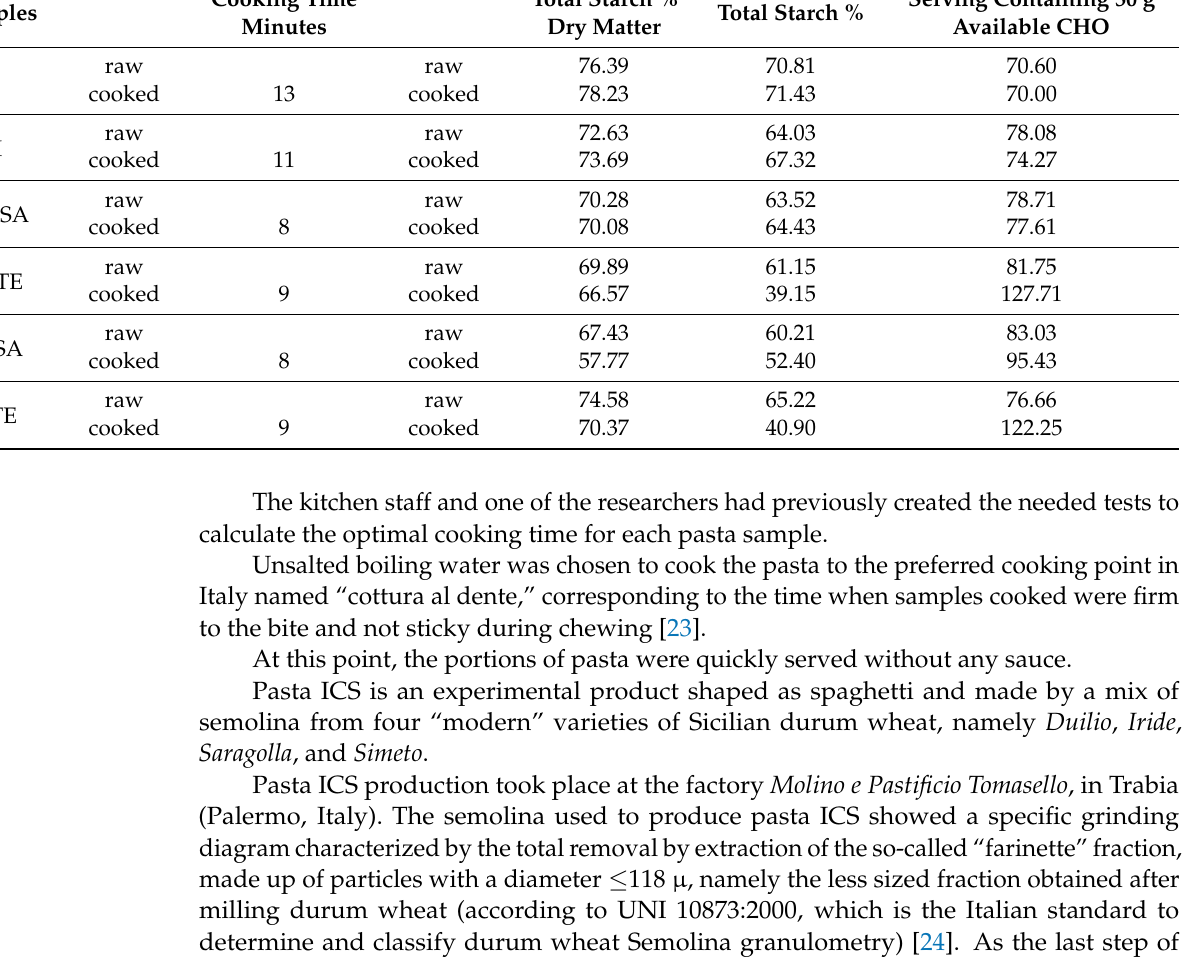
Table 3. Scheme to evaluate 50 g of available carbohydrates for each sample serving. Pasta